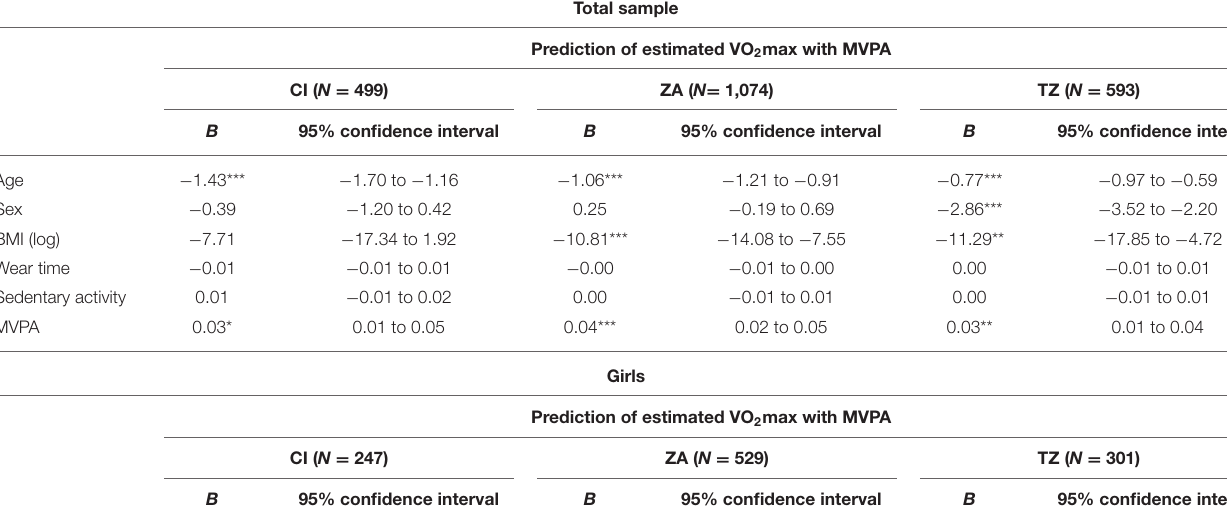
TABLE 5 | Association between children’s physical activity and cardiorespiratory fitness in Côte d’Ivoire (CI), South Africa (ZA), and Tanzania (TZ). Total